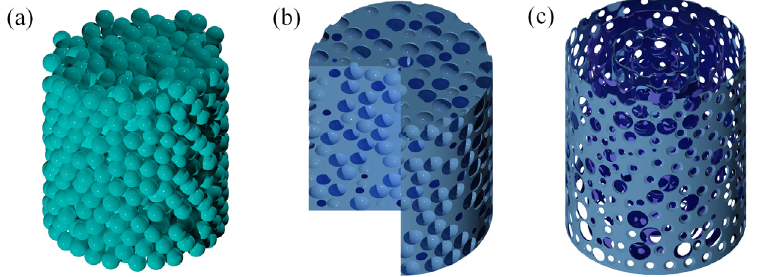
Figure 6. ( a ) Random packing bed based on DEM; ( b ) extraction of pore structure; ( c ) radial annular cylindrical layer.